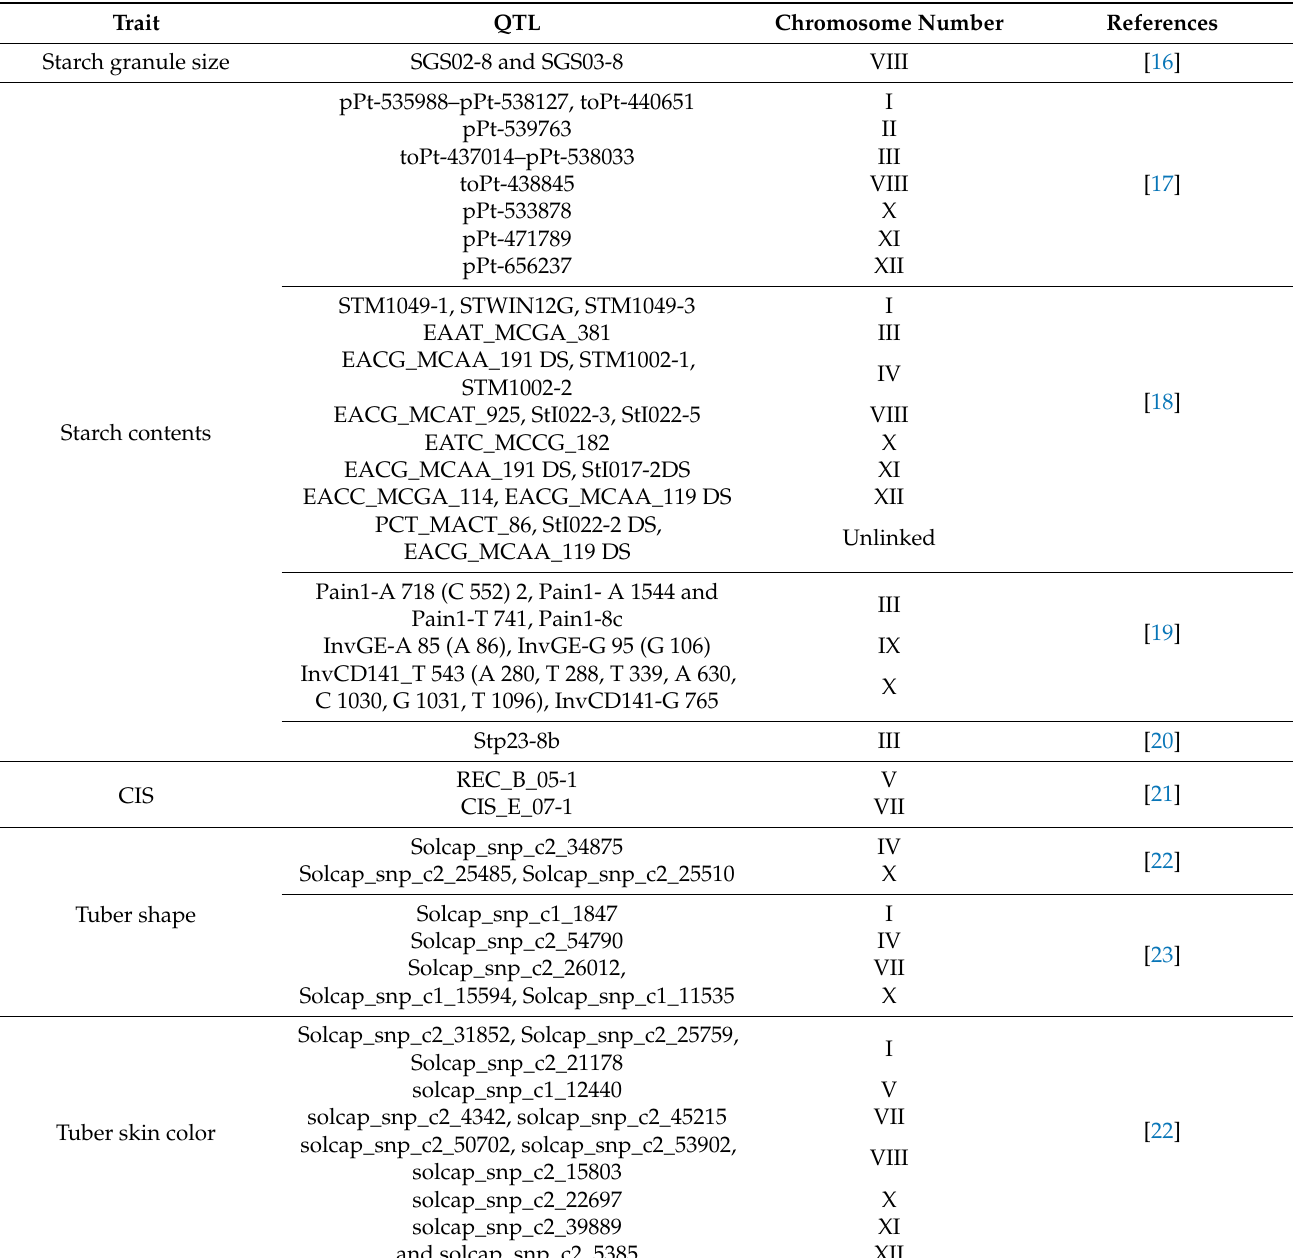
Table 1. QTL for potato tuber quality and quantity